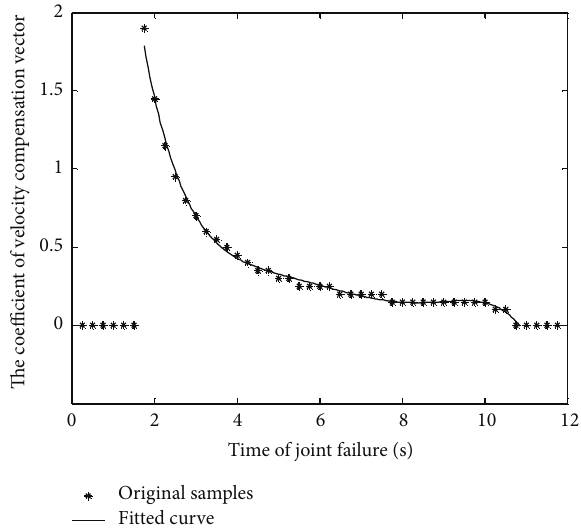
Figure 8: Samples and fitted polynomial function of c 𝑘 (𝑡) .